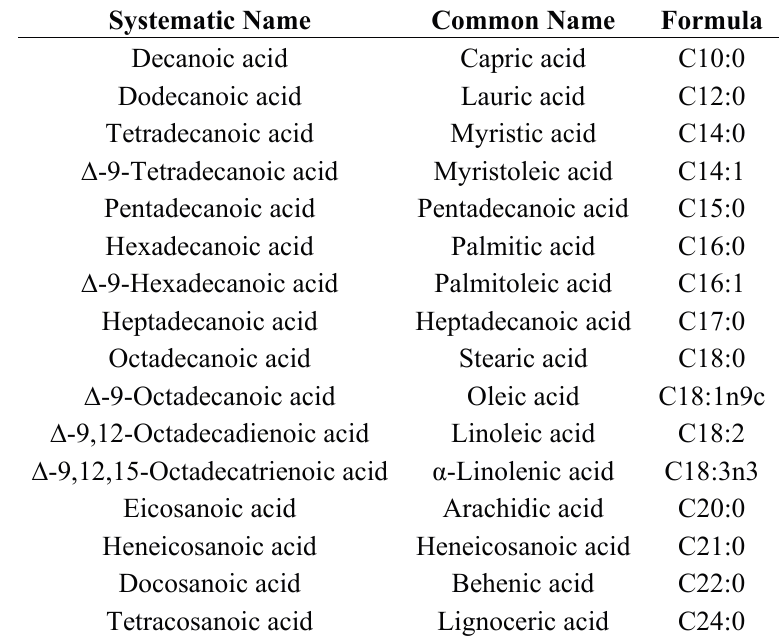
Table 1. Common fatty acids with their chemical formula, common names and